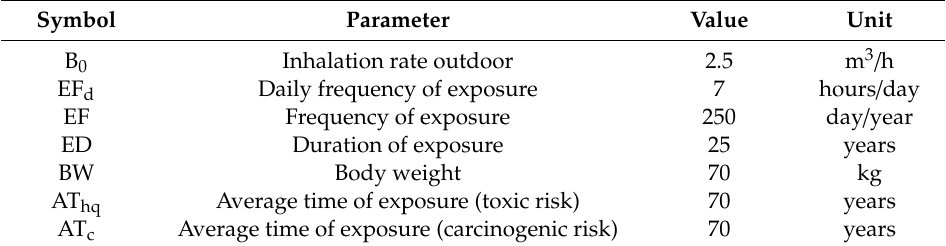
Table 2. Parameters of Equation (3).